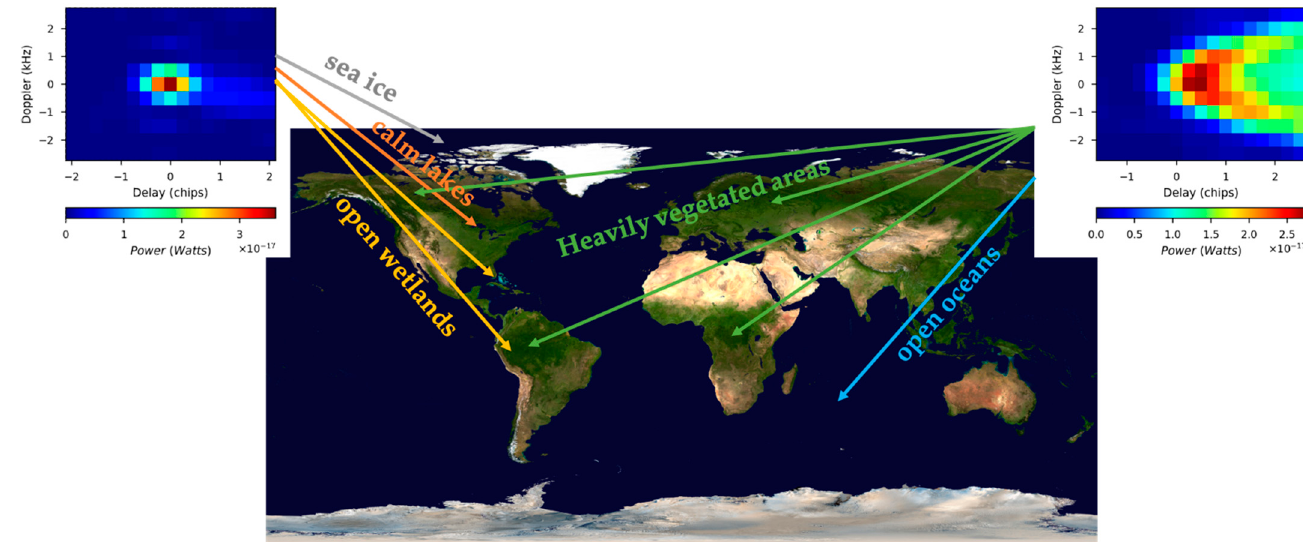
Figure 5. Two examples of delay–Doppler maps (DDM) of two different surfaces. Earth image credit: NASA Goddard Space Flight Center image by Reto Stöckli (land surface, shallow water, clouds).